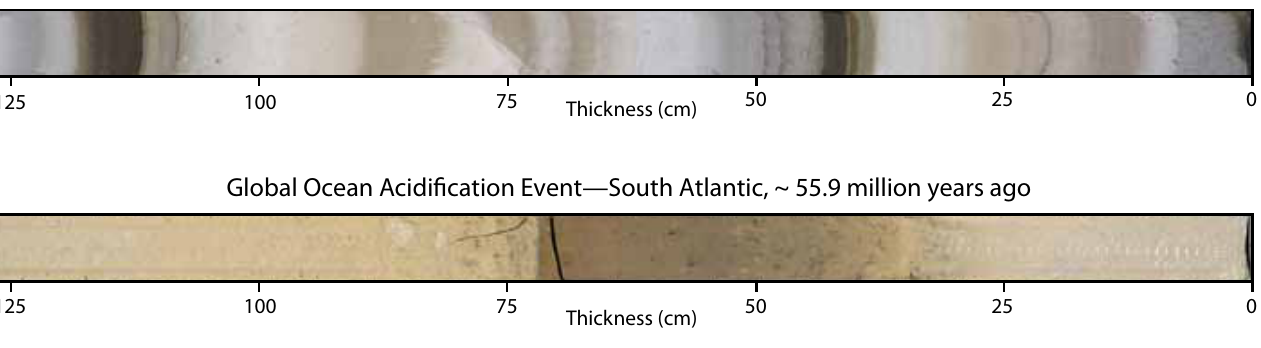
figure 2.12. deep-sea cores record dramatic global and regional ocean acidification and hypoxia. hypoxia, or a pronounced decrease in water-column oxygenation, is expressed by dramatic increases in organic matter preservation that create sapropels (organic-rich sediments). These mediterranean sea (top, core from odp site 964) sapro- pels formed when abrupt surface water warming and freshening, driven by subtle variations in earth’s orbit around the sun, caused pronounced regional circulation changes. The dramatic dissolution of seafloor carbonate that created the red, clay-rich horizon shown in south atlantic odp core 1262 (bottom) was a global event that occurred at the paleocene-eocene boundary ~55.9 million years ago. This global ocean acidification event is believed to have been caused by the release of several trillion tons of carbon into the atmosphere due to thermal dissociation of marine methane hydrates following an ocean warming event. The next phase of ocean drilling must target those locations where sedimentation rates are high enough to preserve the details of how and where acidification and hypoxia develop in the